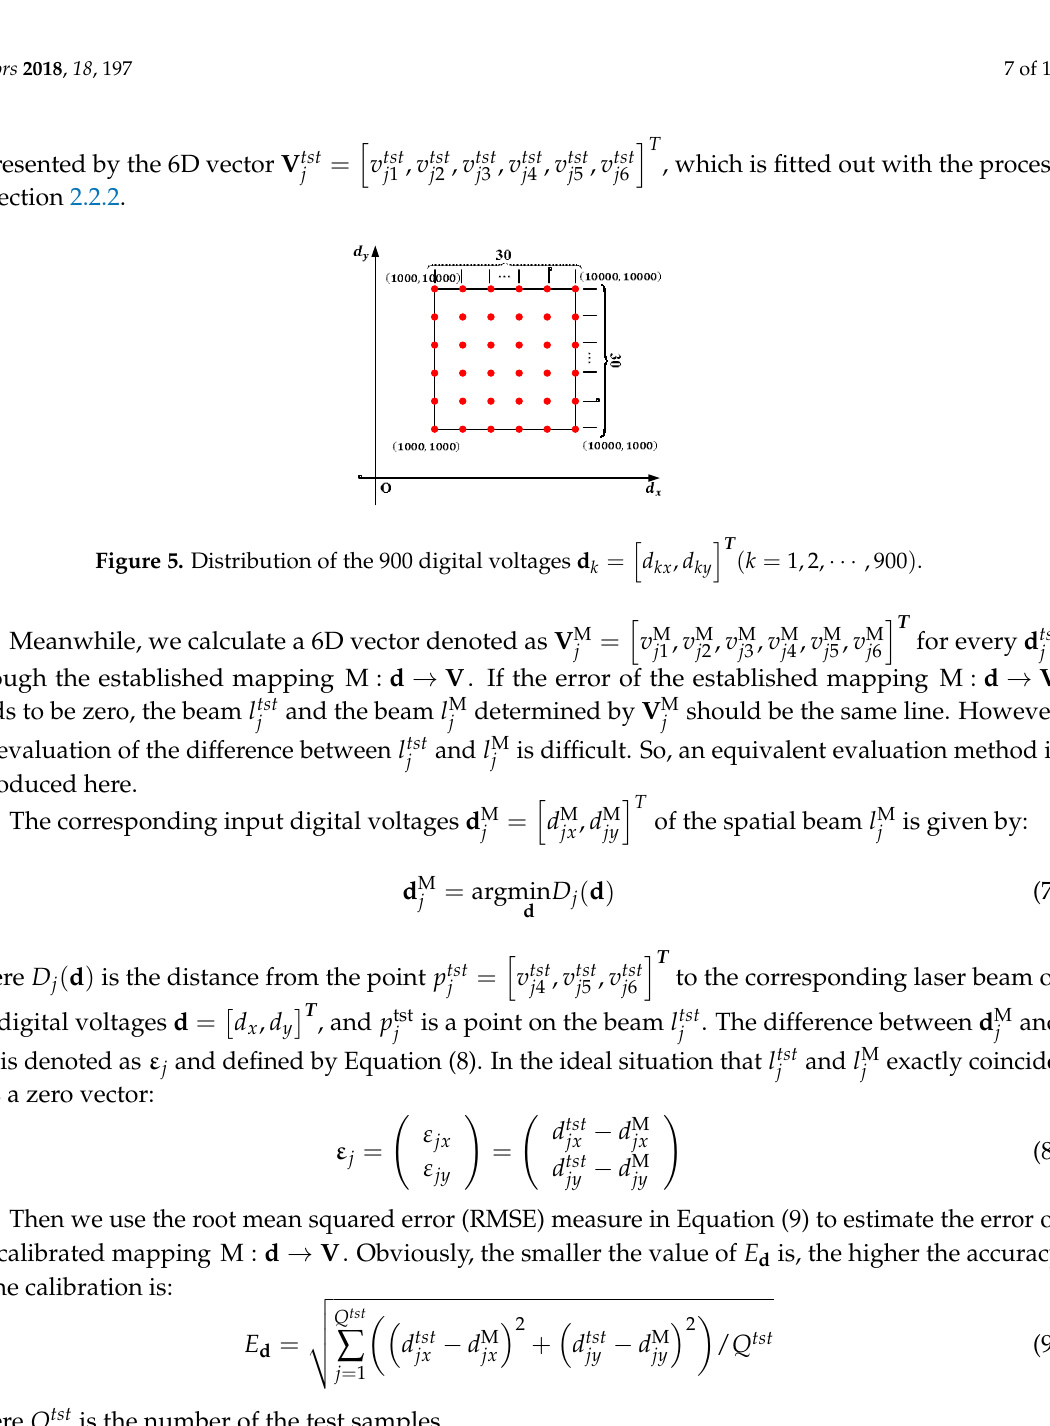
Figure 5. Distribution of the 900 digital voltages (cid:1804) (cid:3038) = (cid:3427)(cid:1856) (cid:3038)(cid:3051) , (cid:1856) (cid:3038)(cid:3052) (cid:3431)